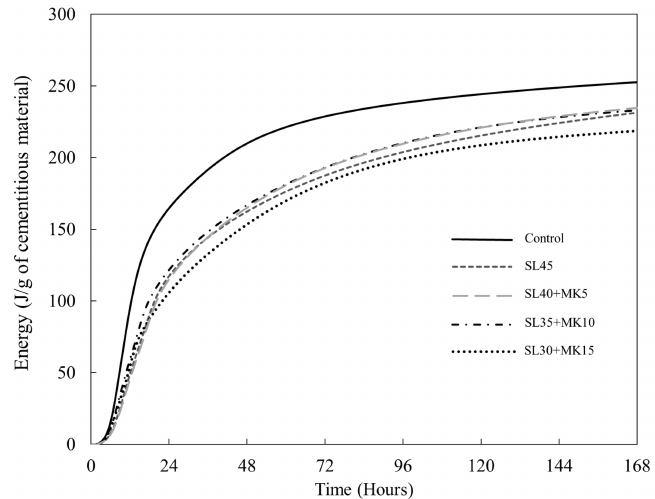
Figure 8. Heat of hydration of binary and ternary mixtures including slag (SL) and metakaolin (MK) in the 422